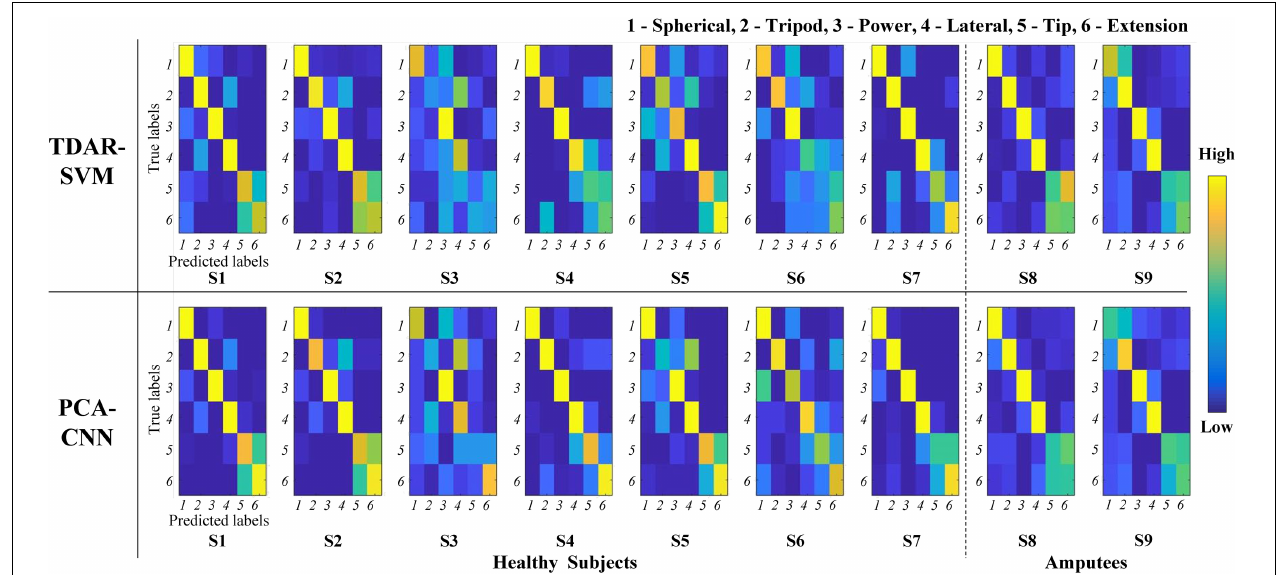
FIGURE 6 | Confusion matrices of classification result from 10-fold cross-validation for healthy subjects and trans -radial and wrist amputees. Y -axis means true labels, and x -axis means predicted labels from classifier. Numbers at true and predicted labels mean reaching-to-grasping tasks (1, spherical; 2, tripod; 3, power; 4, lateral; 5, tip; and 6, extension).